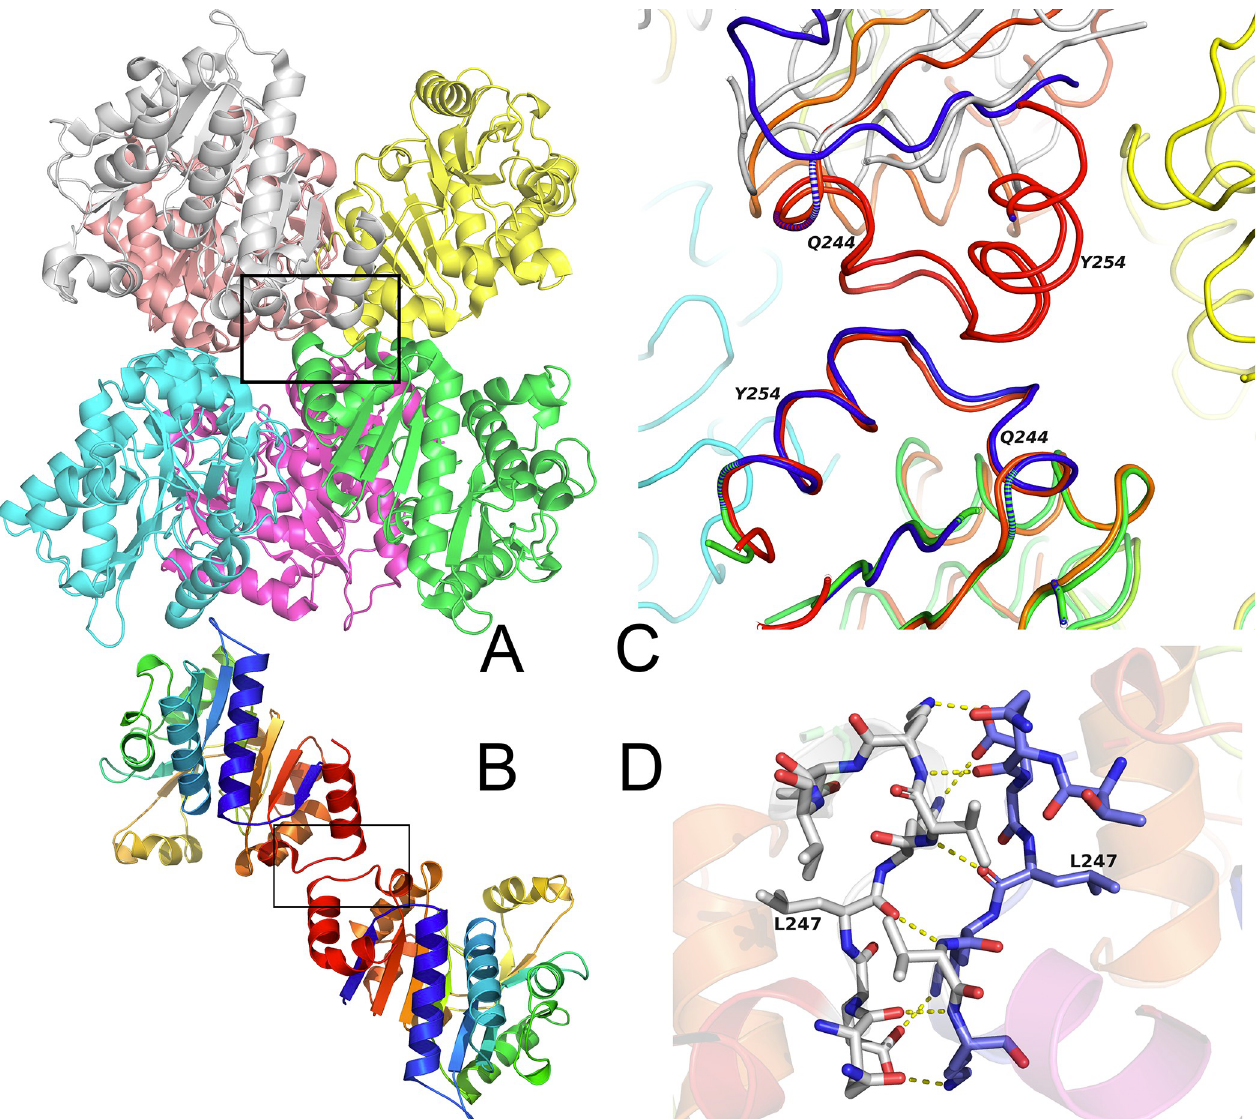
Fig 3. Overall structure. A: Cartoon representation of the Hi NagB hexamer. Each monomer is colored differently. The protein is a trimer of dimers and the orientation shows three subunits at the bottom and three at the top. The black box is the dimer interface. B: Cartoon representation of the Pm NagB dimer. Each monomer is colored as a rainbow–with the N-terminus in Blue and the C-terminus in Red. The black box is the dimer interface. C: The zoomed-up area of the dimer interface–the area that is approximately marked in the black box. One of the subunits of Pm NagB is superposed on one of the subunits of Hi NagB (the green subunit in 3A). Notice that the overlapped subunits superpose well, but the other monomer of the dimer is shifted. D: The interaction of the residues in the dimer interface. There are several main chain hydrogen bonds.